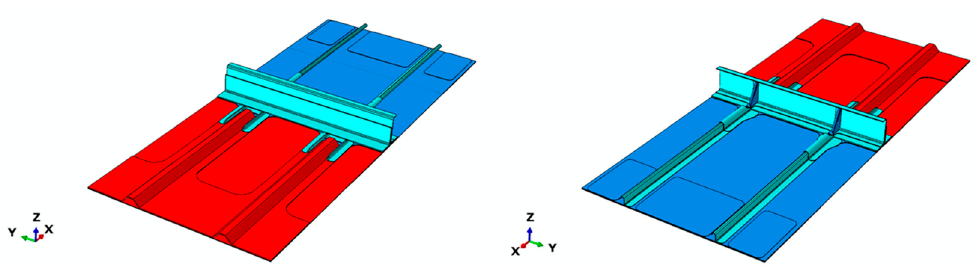
Figure 2. Geometrical model: isometric views.